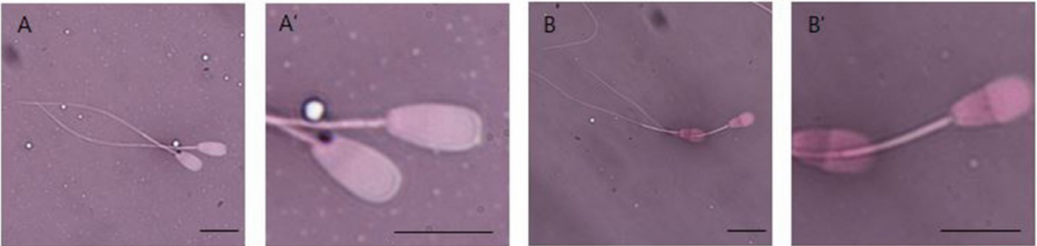
Figure 1. Eosin–nigrosin smear observed in bright field optics. Spermatozoa with red and dark pink heads were considered dead, whereas spermatozoa with white and light pink heads were considered alive. ( A , A (cid:48) ): live sperm; ( B , B (cid:48) ): dead sperm. Scale bars, 5 µ